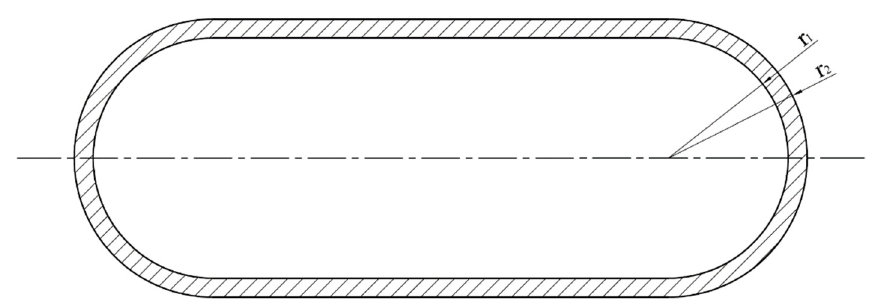
Figure 3. Shape and dimensions of the cylindrical shell.